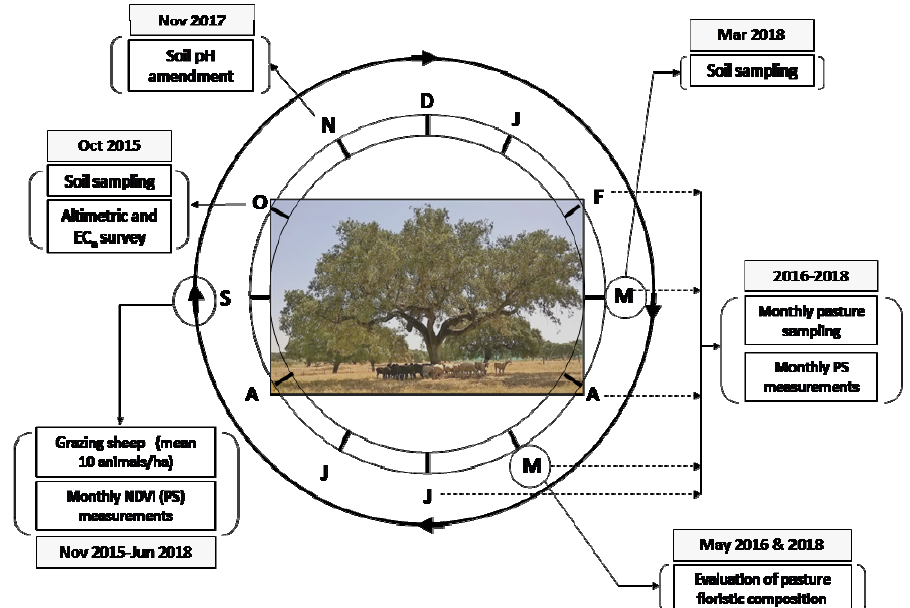
Figure 1. Schedule of activities carried out at the Mitra experimental field to monitor the Montado ecosystem between October 2015 and June 2018 (PS—proximal sensing; EC a —soil apparent electrical conductivity).